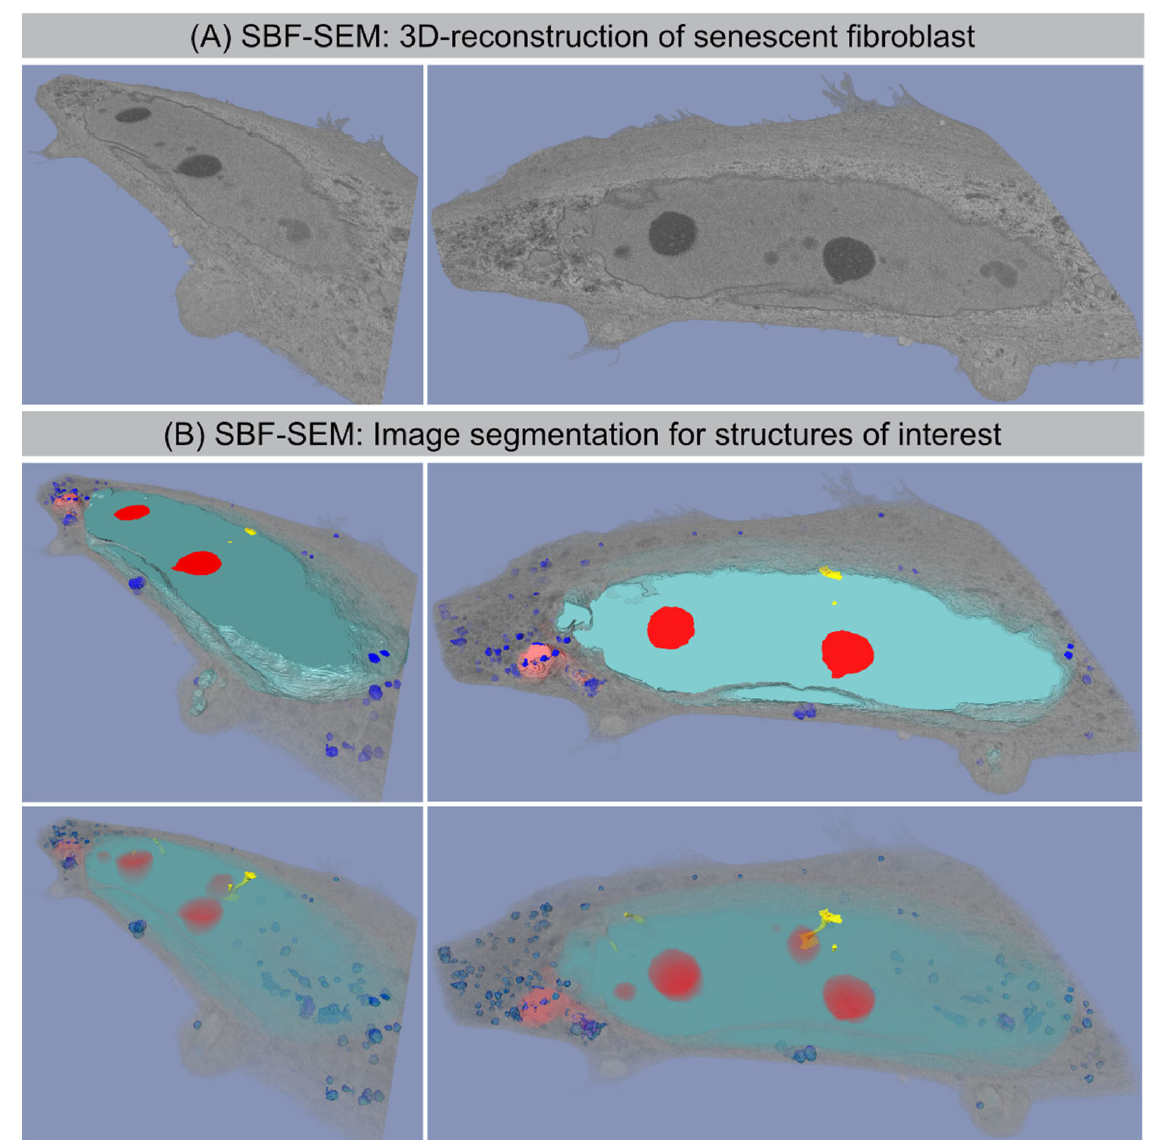
Figure 4. SBF ‐ SEM: 3D reconstruction of senescent fibroblast. ( A ) Original SBF ‐ SEM sections were Figure 4. SBF-SEM: 3D reconstruction of senescent fibroblast. ( A ) Original SBF-SEM sections were used for 3D reconstruction. ( B ) Serial SBF ‐ SEM sections were segmented for structures of interest: used for 3D reconstruction. ( B ) Serial SBF-SEM sections were segmented for structures of interest: nucleus (light ‐ blue), nucleoli (red), lysosomes (blue), and CCF (light ‐ red), nanotubes (yellow), cyto ‐ nucleus (light-blue), nucleoli (red), lysosomes (blue), and CCF (light-red), nanotubes (yellow), cytosol sol (gray) and used for 3D visualization (bottom row: transparent view). (gray) and used for 3D visualization (bottom row: transparent